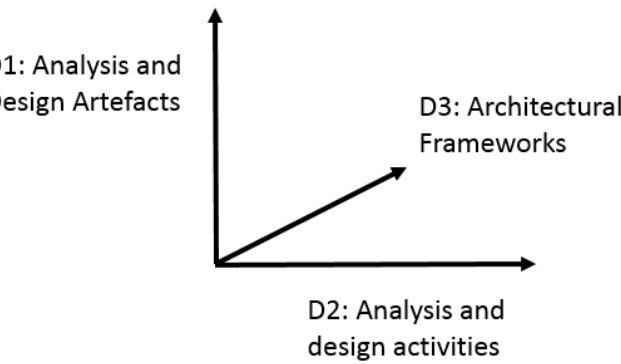
Figure 1. Dimensions of the SERVUS methodology.